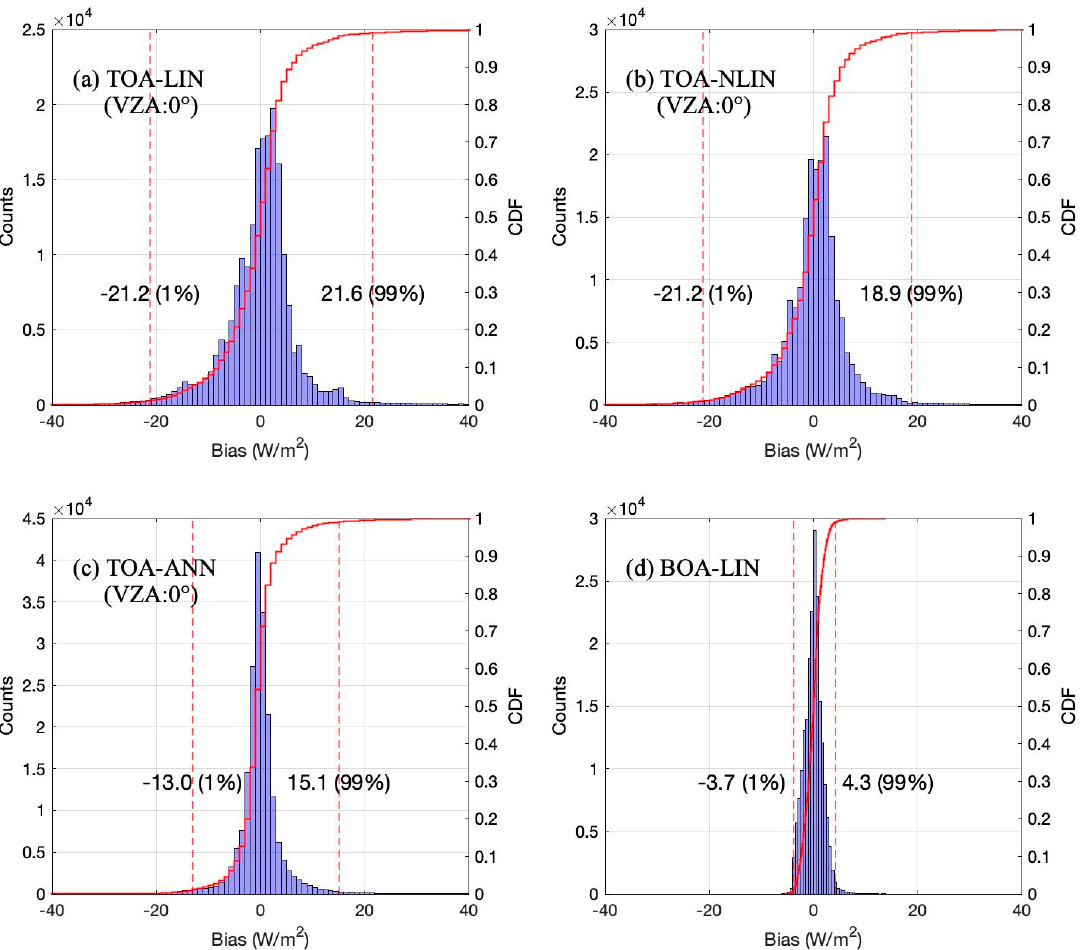
Figure 4. Statistical histograms and CDFs of SULR estimation bias (the red dotted lines indicate the bias values for CDF equal to 1% and 99%). ( a – c ) For the TOA-LIN, TOA-NLIN, and TOA-ANN methods with simulation data of VZA = 0 ◦ with 1 W / m 2 bin size. ( d ) For BOA-LIN methods with all VZA values with 0.5 W / m 2 bin size.